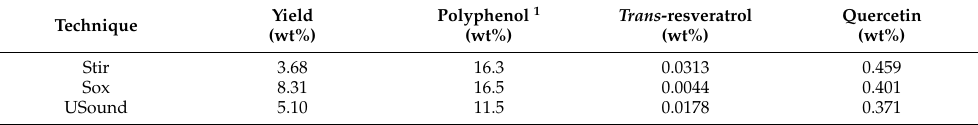
Technique Table 1. Composition of the grape peel extracts produced by various extraction techniques.